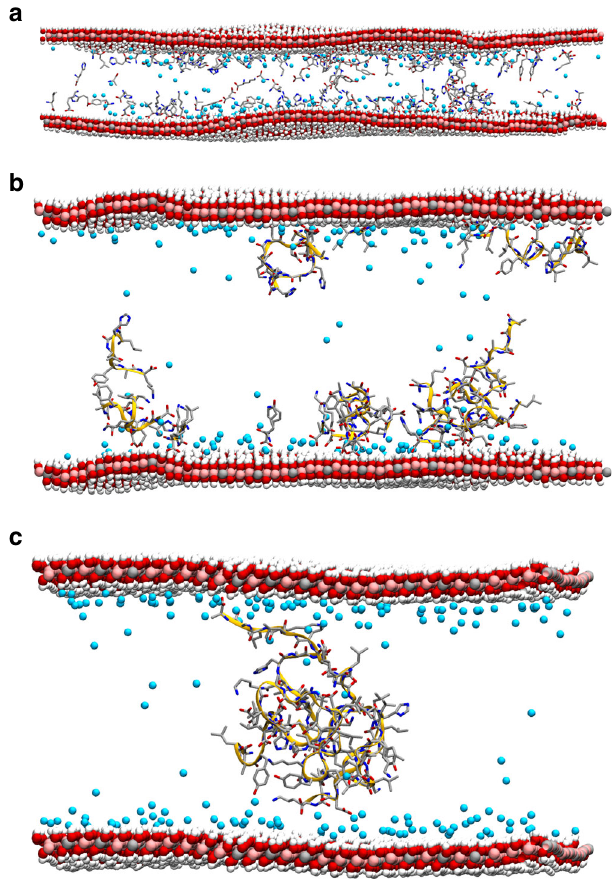
Fig. 1 Amino acids and peptides intercalated in hydrated LDH. Example of modeled systems, showing how natural mixtures of a amino acids, b short, and c long peptides adsorb onto the LDH interlayers via their C-terminal. Colors are as follows: Mg, pink spheres; Al, gray spheres; Cl, blue spheres; O, red; H, white; N, blue; and backbone is represented with a yellow spline. For clarity water and H atoms on the amino acids are not